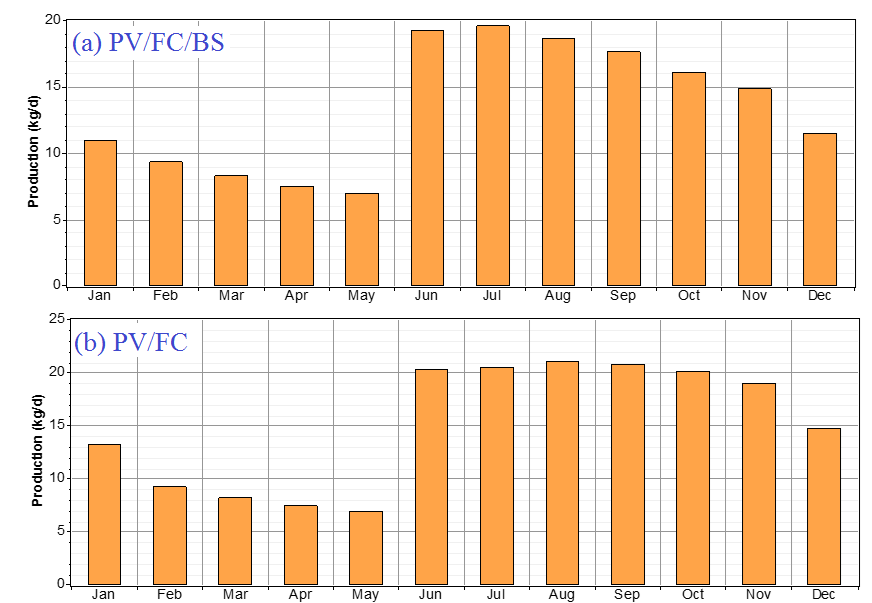
Figure 13. Monthly average hydrogen production.